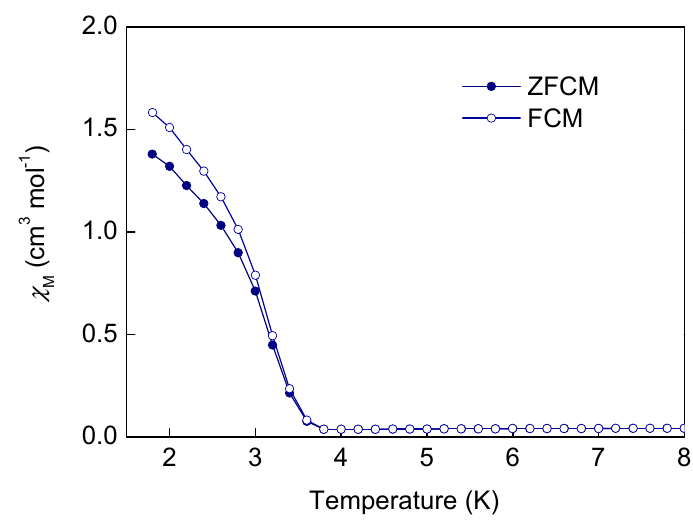
Figure 7. Field-cooled (FC) and zero-field-cooled (ZFC) magnetization plots of compound 1 at the field of 10 G.